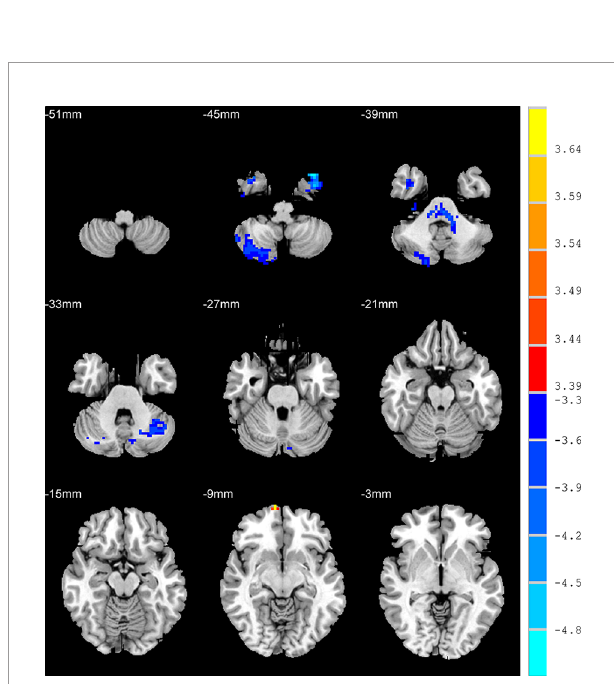
FIGURE 4 | Brain regions show the differences in the amplitudes of low- frequency fl uctuations between unanxious depression group and healthy control group. The color bar signi fi es the t-value of the independent t -tests between the two groups with p < 0.001 and corrected for multiple comparisons using AlphaSim.